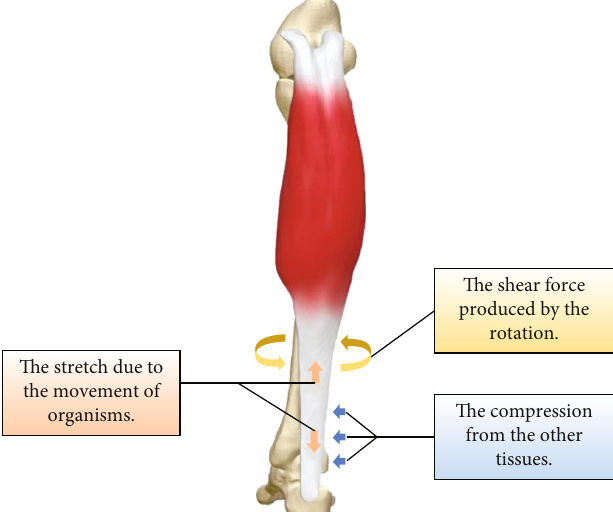
Figure 1: Biomechanical stimulations in natural tendon. Three arrows with di ff erent colors indicate three types of biomechanical stimulations including stretch, shear force, and